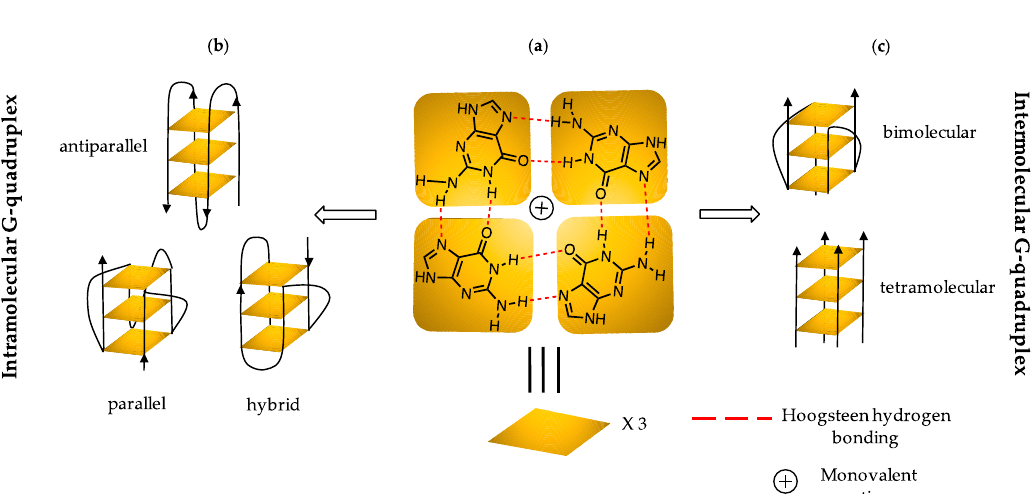
Figure 1. ( a ) Schematic representation of the structural unit of G-quadruplex DNA held together by a cyclic Hoogsteen hydrogen bonding network stabilized by monovalent cations; cartoon representations of: ( b ) intramolecular and ( c ) intermolecular topologies adopted by G-quadruplex DNA (G4 DNA). Arrow direction is from 5’ to 3’.